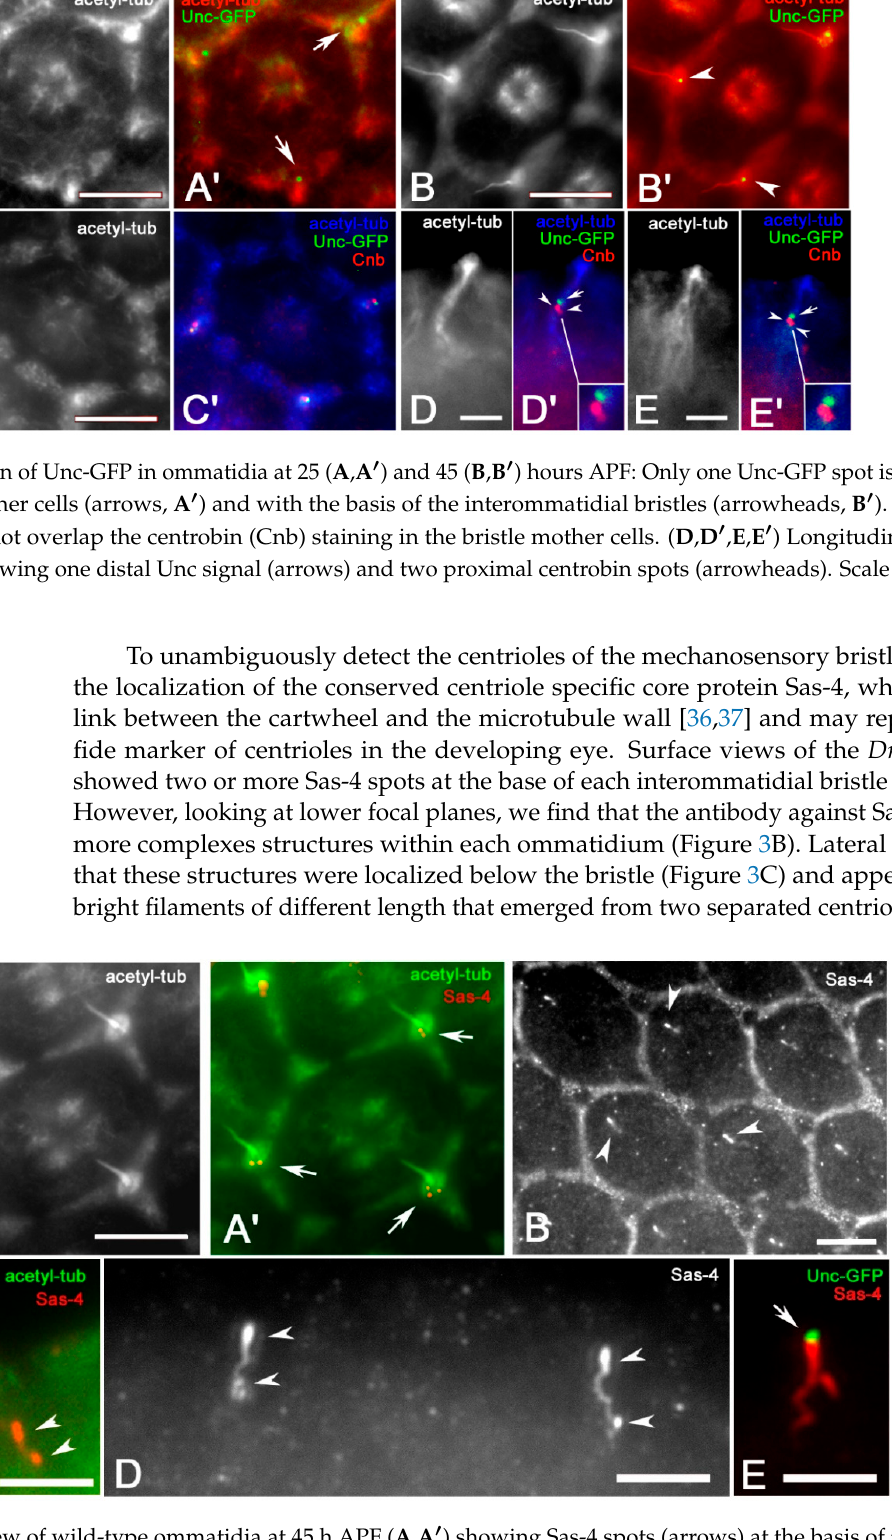
Figure 3. Surface view of wild-type ommatidia at 45 h APF ( A , A ′ ) showing Sas-4 spots (arrows) at the basis of the bristles. ( B ) Lower focus level of ommatidia at 45 h APF showing elongated Sas-4 filaments (arrowheads). ( C ) Lateral view of a bristle and the associated Sas-4 filaments (arrowheads). ( D ) Magnification of paired Sas-4 filaments (arrowheads) from two adjacent ommatidia. ( E ) The Unc-GFP signal is only associated with the apical end of the more elongated Sas-4 filament. Scale bars: 5 µm ( A , B ), 2.5 µm ( C – E ).